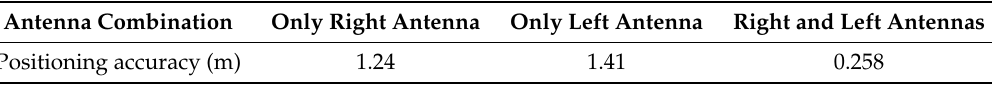
Table 2. Comparison of positioning accuracy in meters under different antenna combinations. Antenna Combination Only Right Antenna Only Left Antenna Right and Left Antennas Positioning accuracy (m) 1.24 1.41